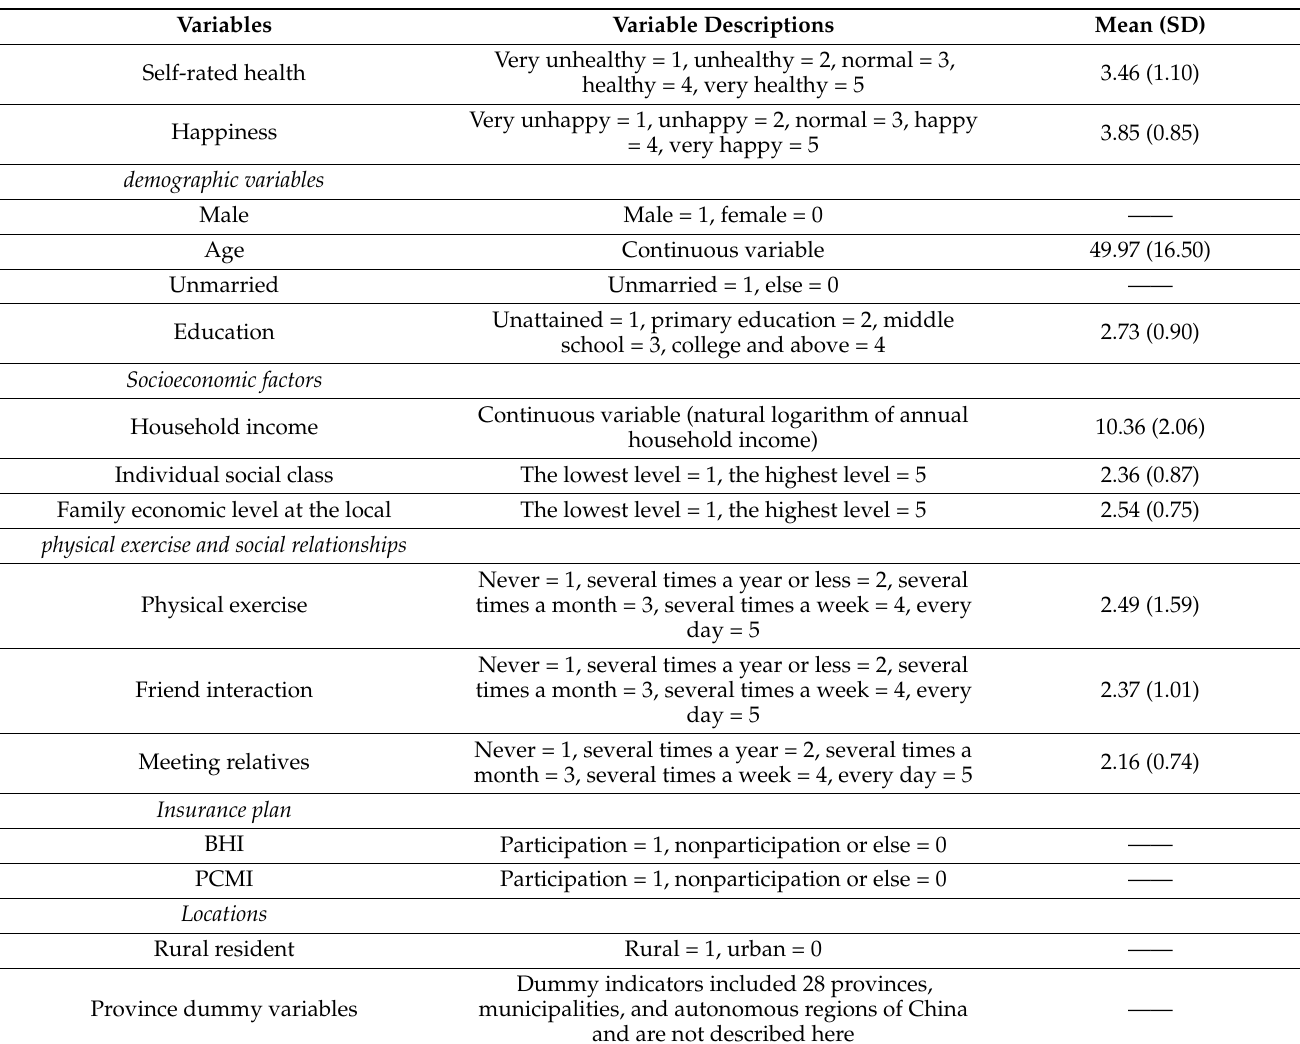
Table 1. Variable descriptions in the model ( n = 11,009). Abbreviations: basic medical